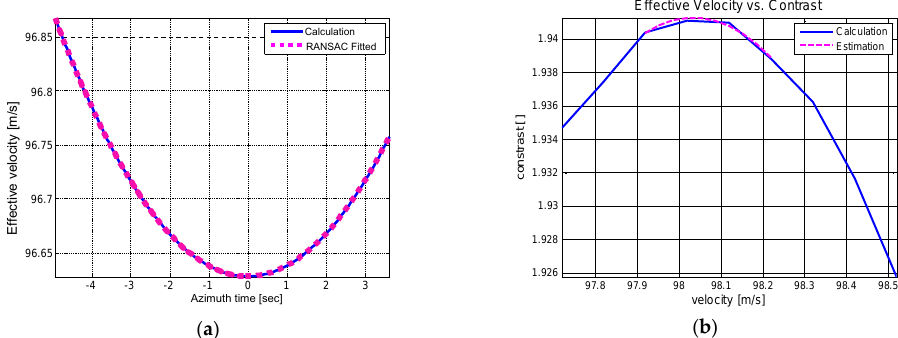
Figure 12. Effective velocity estimation of Boeing 747 ISAR data ( a ) Initial coarse velocity estimation ( b ) CMA based effective velocity estimation.